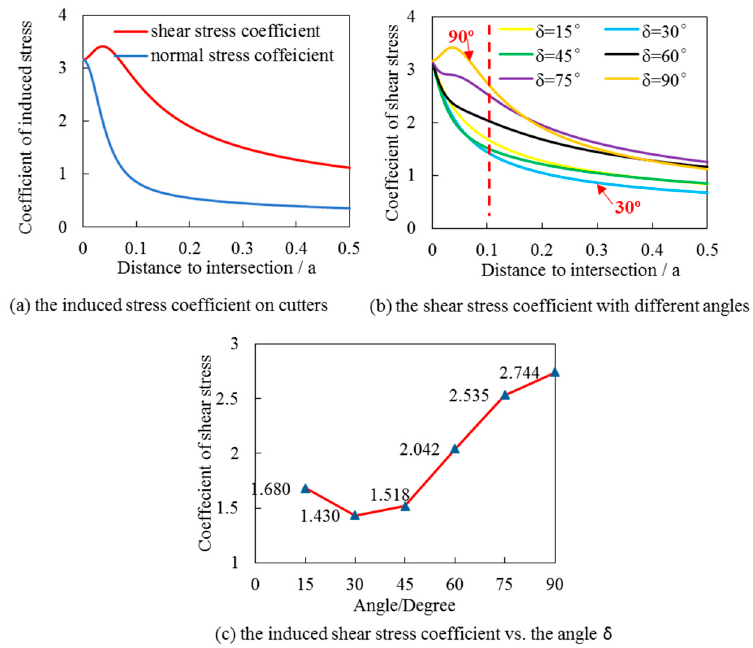
Figure 11. Induced stress coefficient on cutters of ( a ) shear and normal stress ( δ = 90 º ), ( b ) shear stress with different angles, and ( c ) with angle δ .